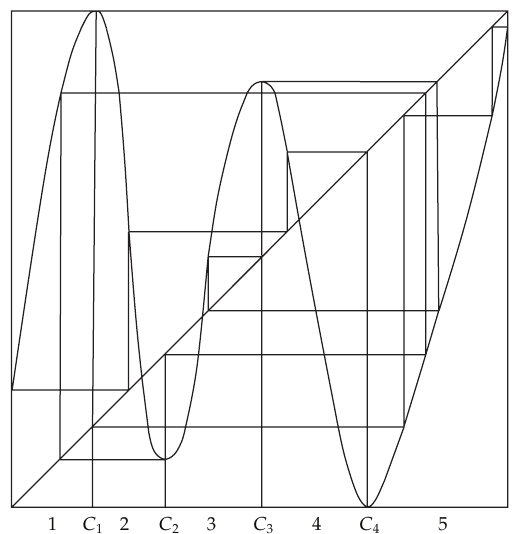
Figure 1: Graph of the map f characterized by the kneading invariant K f (cid:5) (cid:2)(cid:2) 555 C 1 (cid:3) ∞ , (cid:2) 15 C 2 (cid:3) ∞ ,